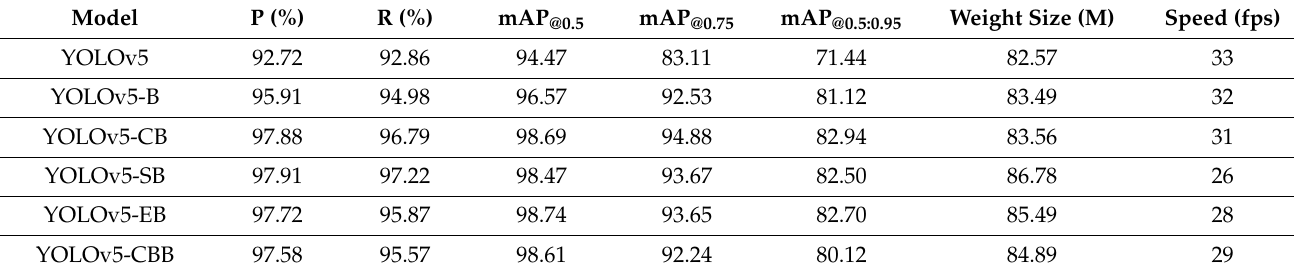
Table 5. Results of the ablation